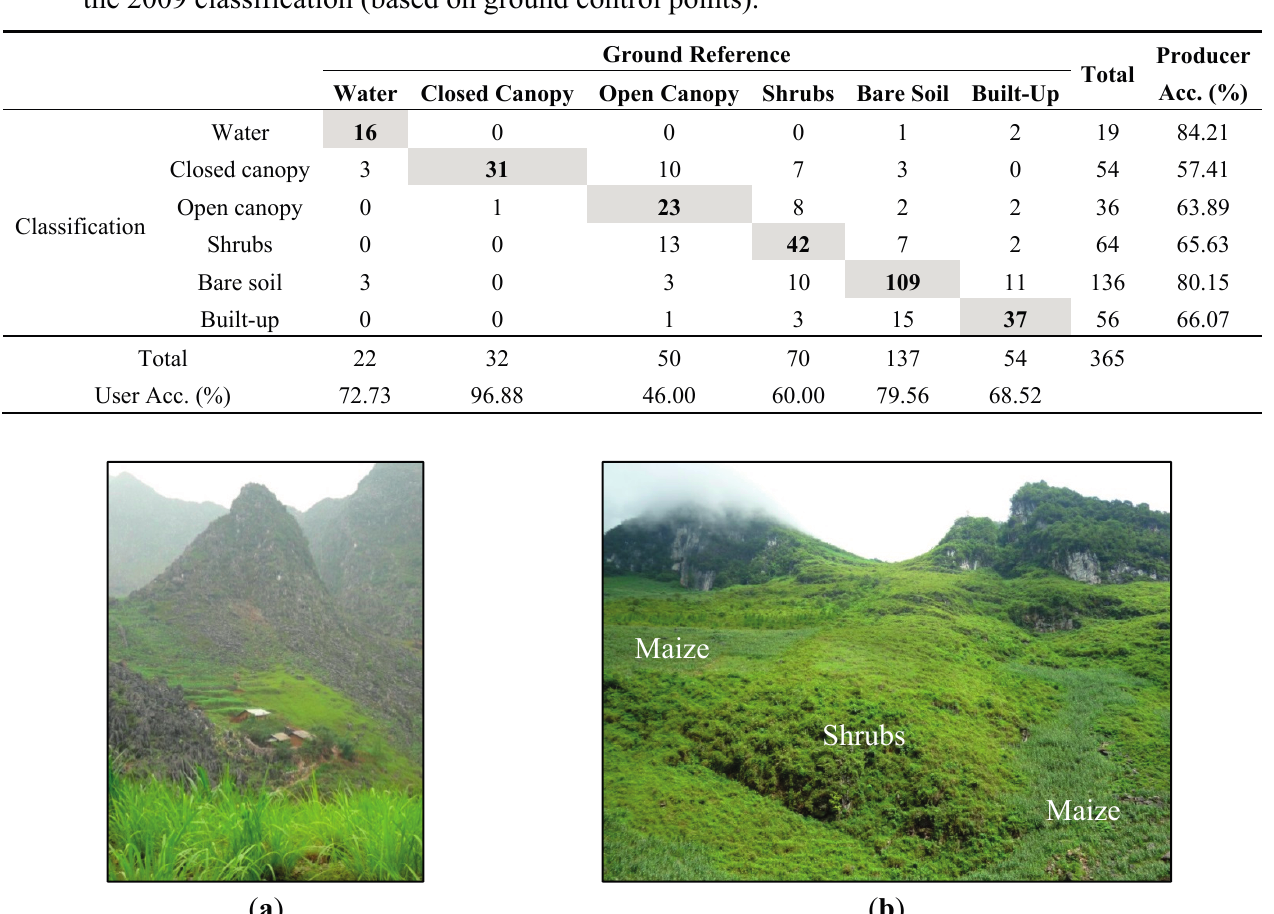
Table 2. Confusion matrix and producer’s and user’s accuracy for accuracy assessment of the 2009 classification (based on ground control points).